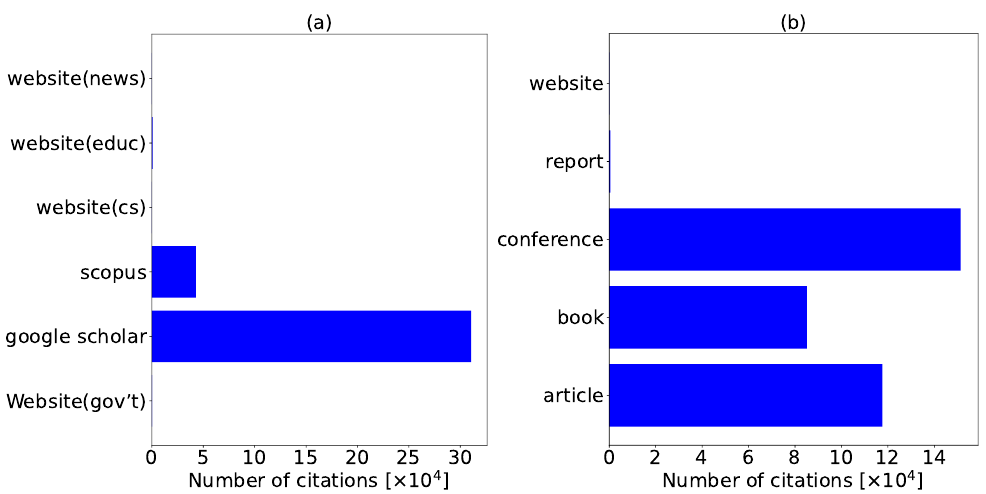
Figure 4. ( a ) Displays the total number of citations per database, and ( b ) visualizes the number of manuscript citations per document